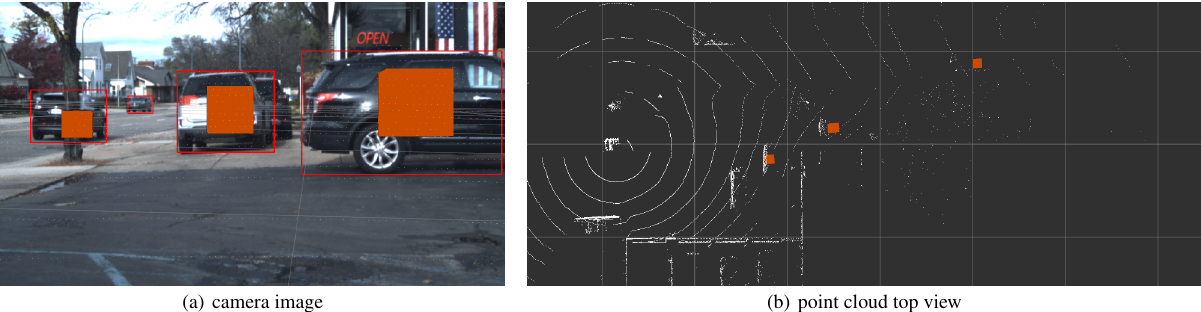
Figure 5. Object detection results for an urban scenario. (a) Camera image overlayed with bounding boxes calculated by the CNN (red rectangles around vehicles) and 3D centroids projected into the image (orange cubes). (b) Top view of the Lidar point cloud (white dots) with calculated object centroids (orange cubes). Ego vehicle is located at the left boundary of the figure. Grid cells have a size of 10 by 10 meters. Due to the K-means clustering the centroid of the car on the left occluded by a tree is still calculated correctly. For the far distant car detected by the CNN no centroid was calculated since it is confirmed by only little number of Lidar points.